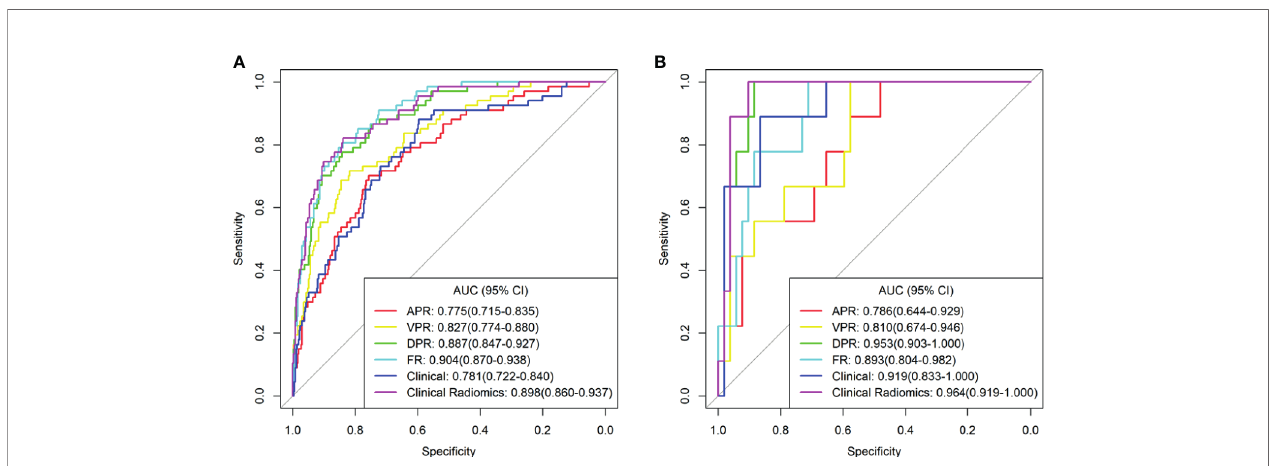
FIGURE 3 | The receiver operating characteristic (ROC) curves of the different models in training cohort (A) and validation cohort (B) . AUC, area under the curve; APR, radiomics model of arterial phase; DPR, radiomics model of delayed phase; VPR, radiomics model of venous phase; FR, radiomics model of fusion of arterial phase, delayed phase and venous phase features; Clinical Radiomics, fusion of clinical risk factors and radiomics features of delayed